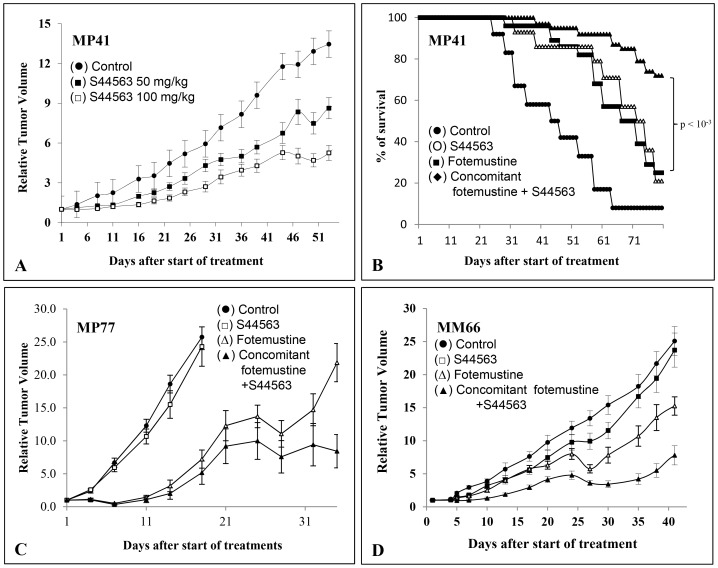

In vivo responses of UM PDXs to S44563 administered alone or in combination with fotemustine.A. MP41 xenograft was treated either by S44563 at 50/kg (▪) or 100 mg/kg (□) 5 days a week for 5 weeks. B. Overall survival of mice bearing MP41 tumors treated by S44563 (O), fotemustine (▪), and concomitant fotemustine+S44563 (⧫). C. MP77 xenograft was treated by S44563 at 100 mg/kg (□), fotemustine 15 mg/kg (Δ), or both (▴). D. MM66 xenograft was treated by S44563 at 50 mg/kg (□), fotemustine 30 mg/kg (Δ), or both (▴). Mice in the control group (•) received 0,3 ml of the drug-formulating vehicle with the same schedule as the treated animals. Tumor growth was evaluated by plotting the mean of the RTV (relative tumor volume) ± SD per group. Between 8 to 12 mice per group were included in in vivo experiments.